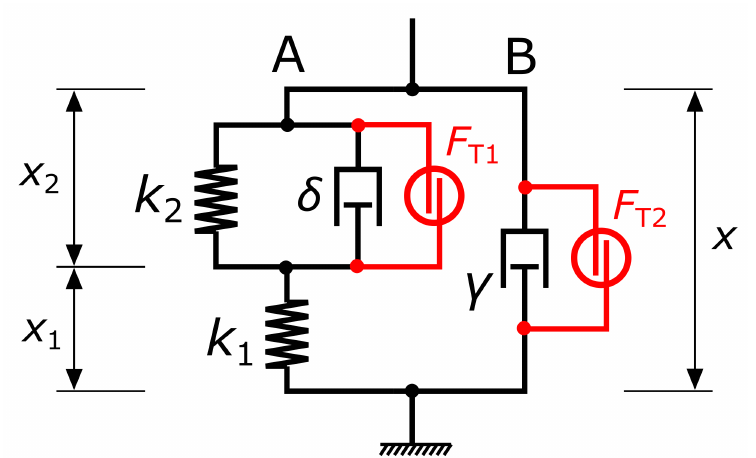
Figure 2. The schematic depiction of the linear mechanical model for the microbead motion. Arms A and B represent the nanowire and the hydrodynamic damping by the surrounding medium, respectively. The internal characteristics x 1 , x 2 are related to the total observable parameter x